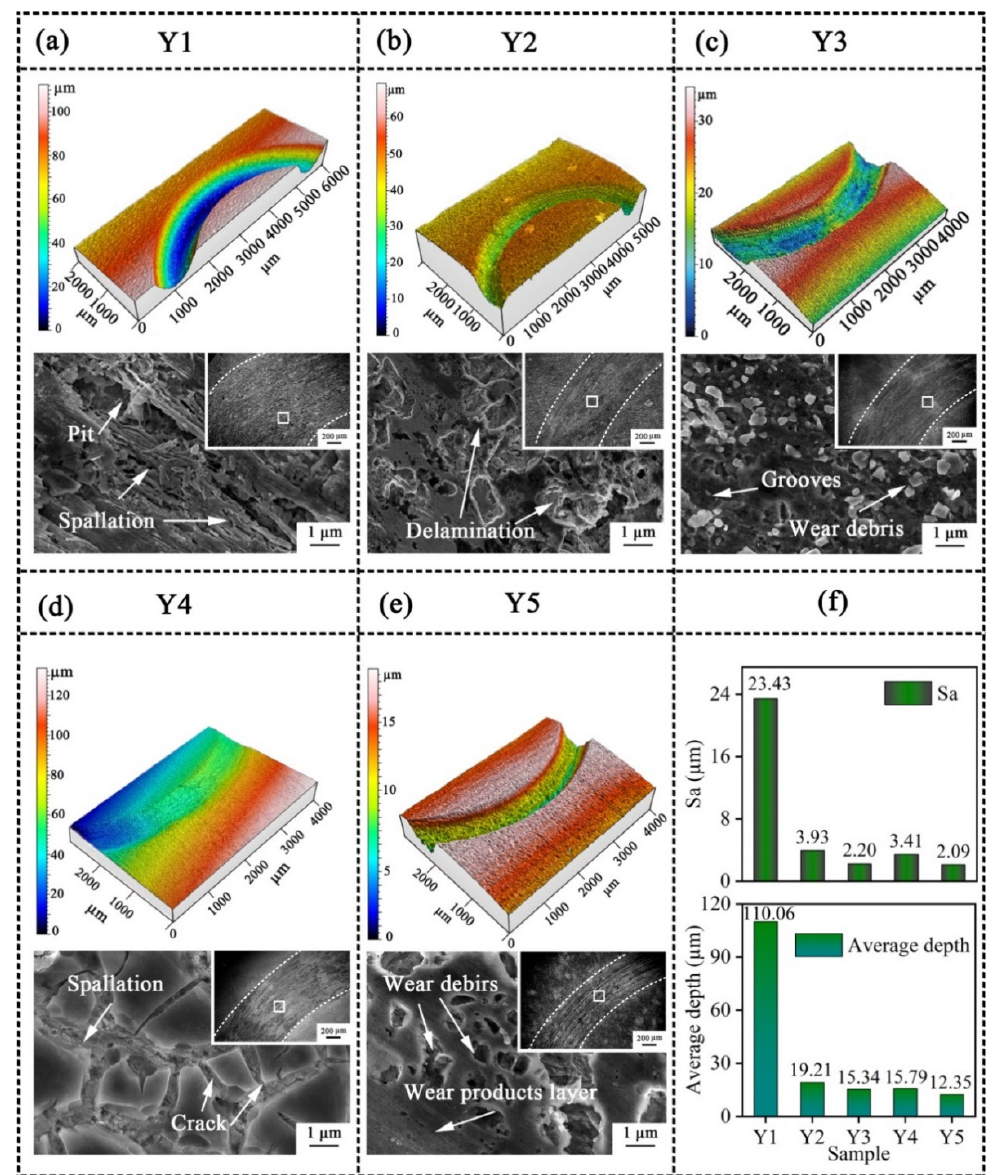
Figure 4. Three-dimensional morphology and SEM image of coating: ( a ) Y1, ( b ) Y2, ( c ) Y3, ( d ) Y4, ( e ) Y5. ( f ) Surface roughness (Sa) of wear specimens and average wear depth.